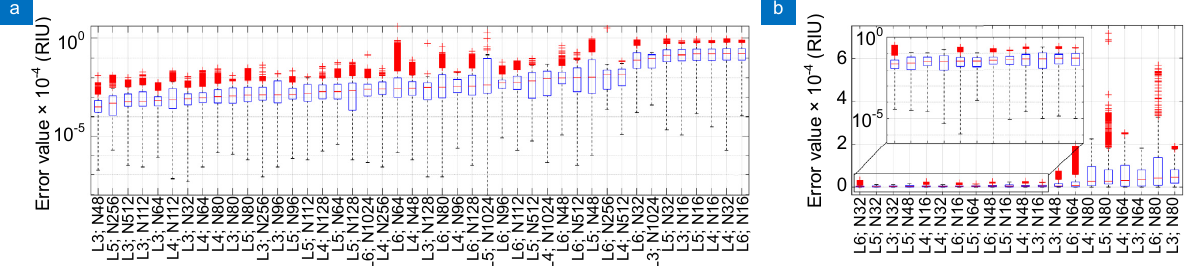
Fig. 6 | Statistics on the refractive index prediction accuracy represented as absolute error values for different dNN configurations with varying number of neurons (N) in the input layer ( n = 16, 32, 48, 56, 64, 80, 96, 112, 128, 256, 512, 1024) and hidden layers (L) number (3, 4, 5, 6) with 2 n neurons. ( a ) The results for the case when the dataset including all RIU output states has been used in training. ( b ) The results for the experimental data set when a particular RIU output state has been